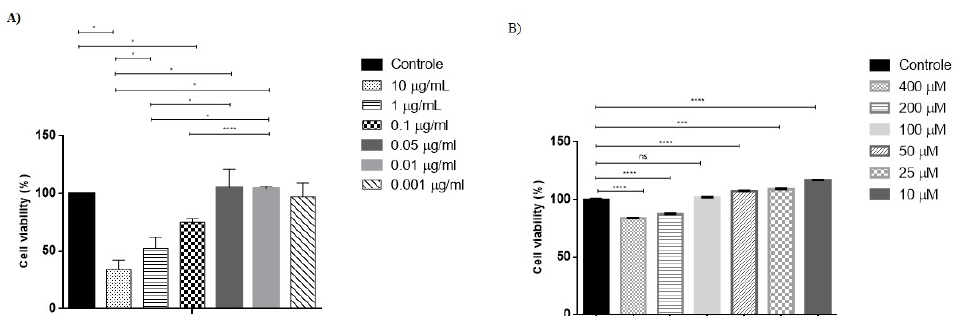
Figure 1. Effect of extract ( A ) and gallic acid ( B ) on cell viability. Melanocyte viability was assessed by MTT after 48 h incubation with cell culture media as positive control (C+), extract and gallic acid. Each bar represents the mean ± SD of 3 independent experiments. * p < 0.05; *** p < 0.001; **** p < 0.0001; ns = non-significant.